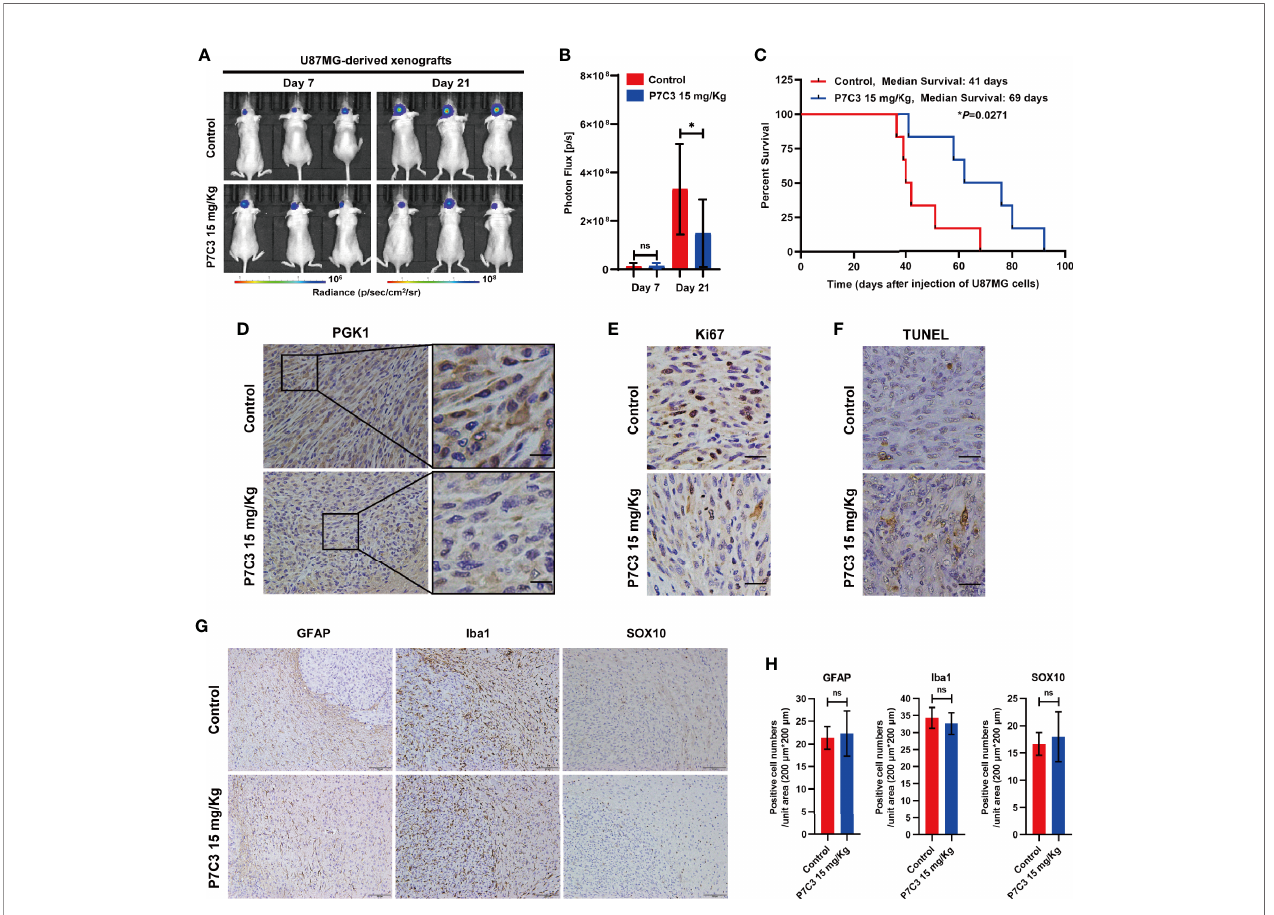
FIGURE 7 | P7C3 inhibits glioma in vivo . (A) Representative in vivo IVIS Luc fl uorescence images of xenografts mice on days 7 and 21 after injection of U87MG cells. (B) Statistical result of photon fl ux in xenografts mice on days 7 and 21 (n = 12). (C) Kaplan – Meier curves of survival rate of xenografts mice (n = 6). (D) Immunohistochemical staining of PGK1 in the indicated tumor tissues was performed, PGK1 positive cells were stained brown (scale bar: 20 m m). (E) Immunohistochemical staining of Ki67 in the indicated tumor tissues was performed. Ki67 positive cells were stained brown (scale bar: 50 m m). (F) TUNEL analyses of the indicated tumor tissues were performed. Apoptotic cells were stained brown (scale bar: 50 m m). (G) Immunohistochemical staining of labeling astrocytes, microglia, and oligodendrocytes in the mice brain by using GFAP, Iba1, and SOX10, respectively (scale bar: 100 m m). (H) Statistical analysis of GFAP-positive, Iba1- positive, and SOX10-positive cells in the mouse brain (n = 3). (The data were expressed as mean ± SD, ns P > 0.05, * P < 0.05, ns means none signi fi